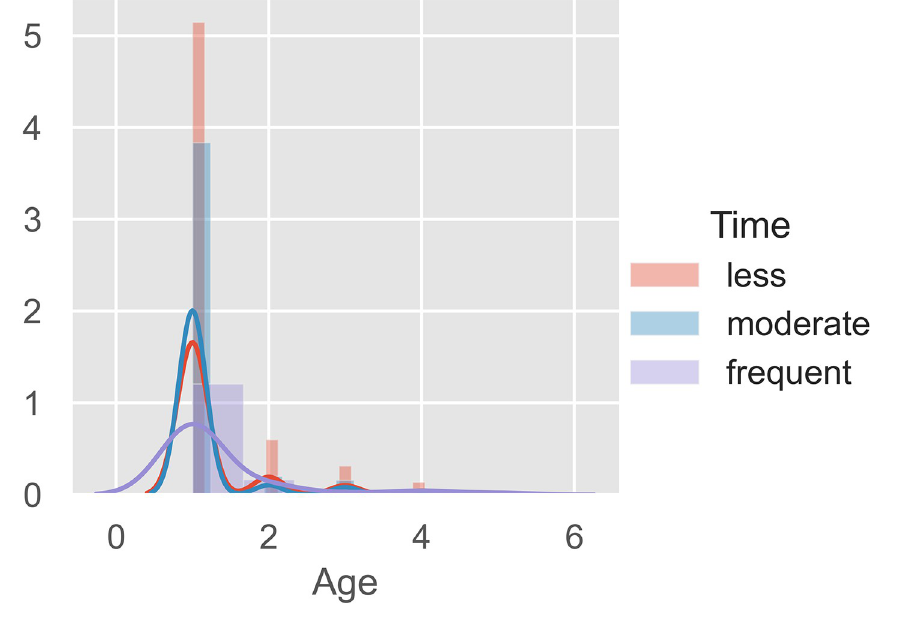
Fig 5. Cluster visualization through age.